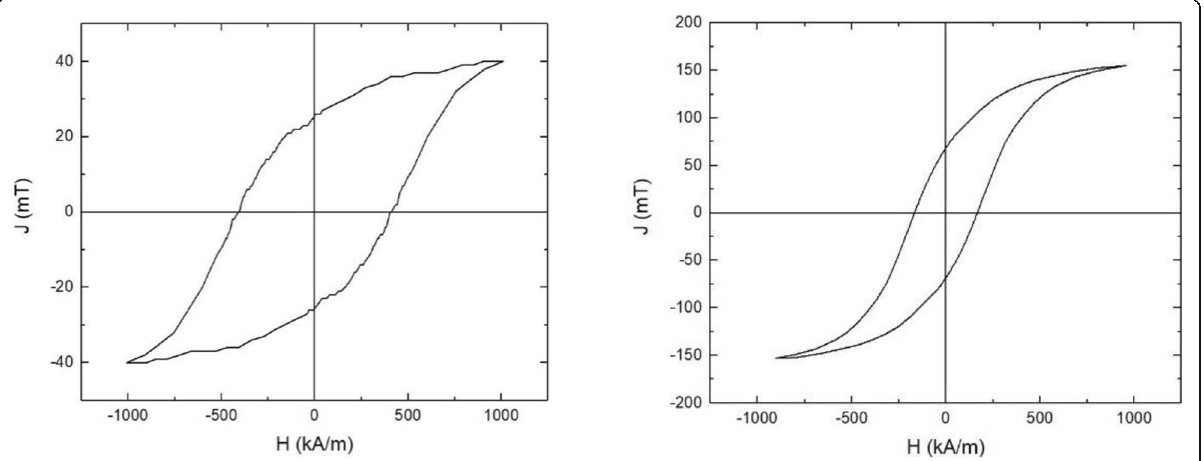
Fig. 14 Hysteresis loop for PEEK_25NdFeB printed magnet (left) and PEEK_50NdFeB printed magnet (right)